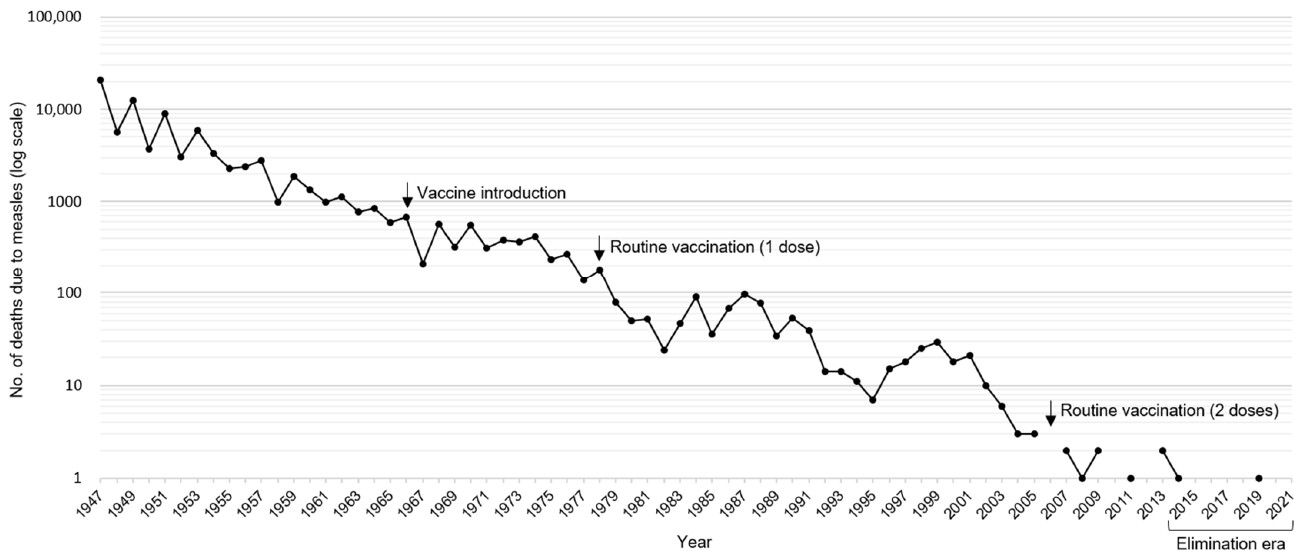
Figure 1. Number of measles deaths in Japan in 1947 − 2021 [20,21]. The number of deaths has smoothly declined, mainly because of Japan’s national vaccination policies (arrows). The vertical axis is denoted by the log scale since the number of deaths declined sharply from 20,939 in 1947 to 0 in 2021.